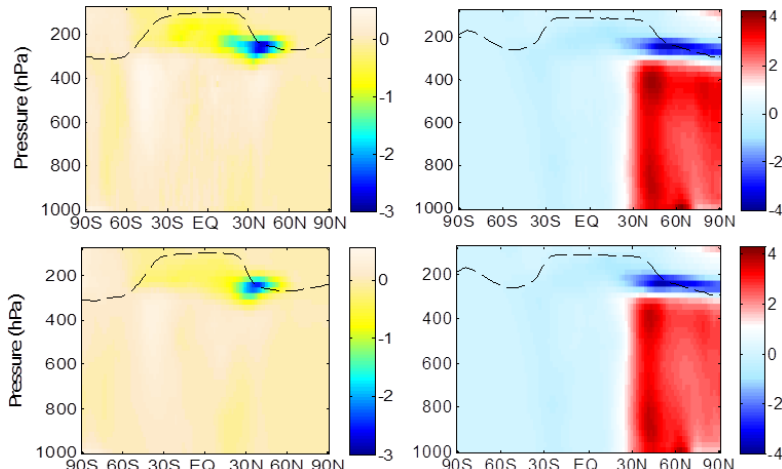
Figure 9. As in Fig. 7, but for HO 2 (10 − 6 1 moleccm − 3 )